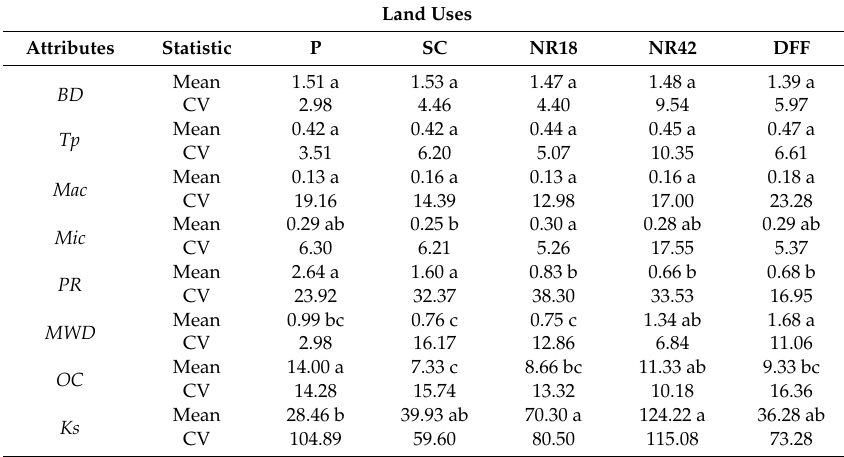
Table 2. Average values of the hydrophysical attributes of the soils in the study areas. BD : bulk density (g cm − 3 ); Tp : total porosity (cm 3 cm − 3 ); Mac: macroporosity (cm 3 cm − 3 ); Mic : microporosity (cm 3 cm − 3 ); PR : penetration resistance (Mpa); MWD : mean weight diameter of the soil aggregates (mm); OC